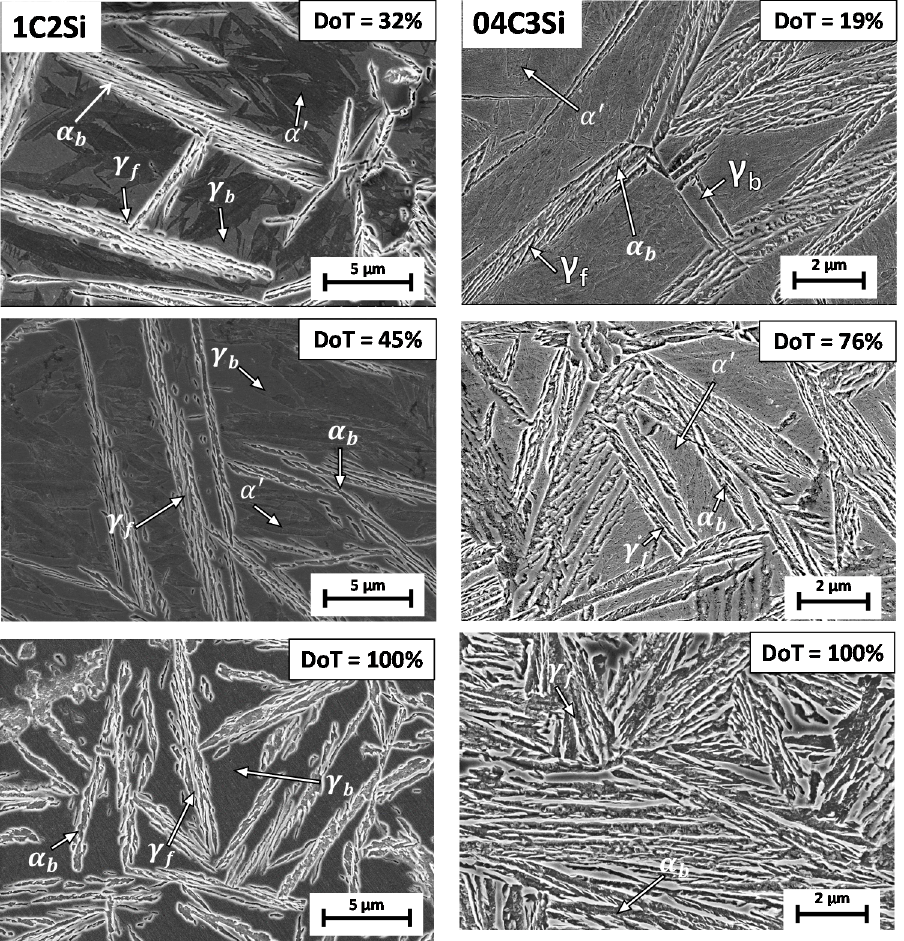
Figure 8. Examples of the evolution of the 350 °C microstructure for both alloys. DoT stands for the degree of transformation, α b stands for bainitic ferrite, α (cid:48) stands for martensite and γ stands for retained austenite with film (f) and block (b) morphology.